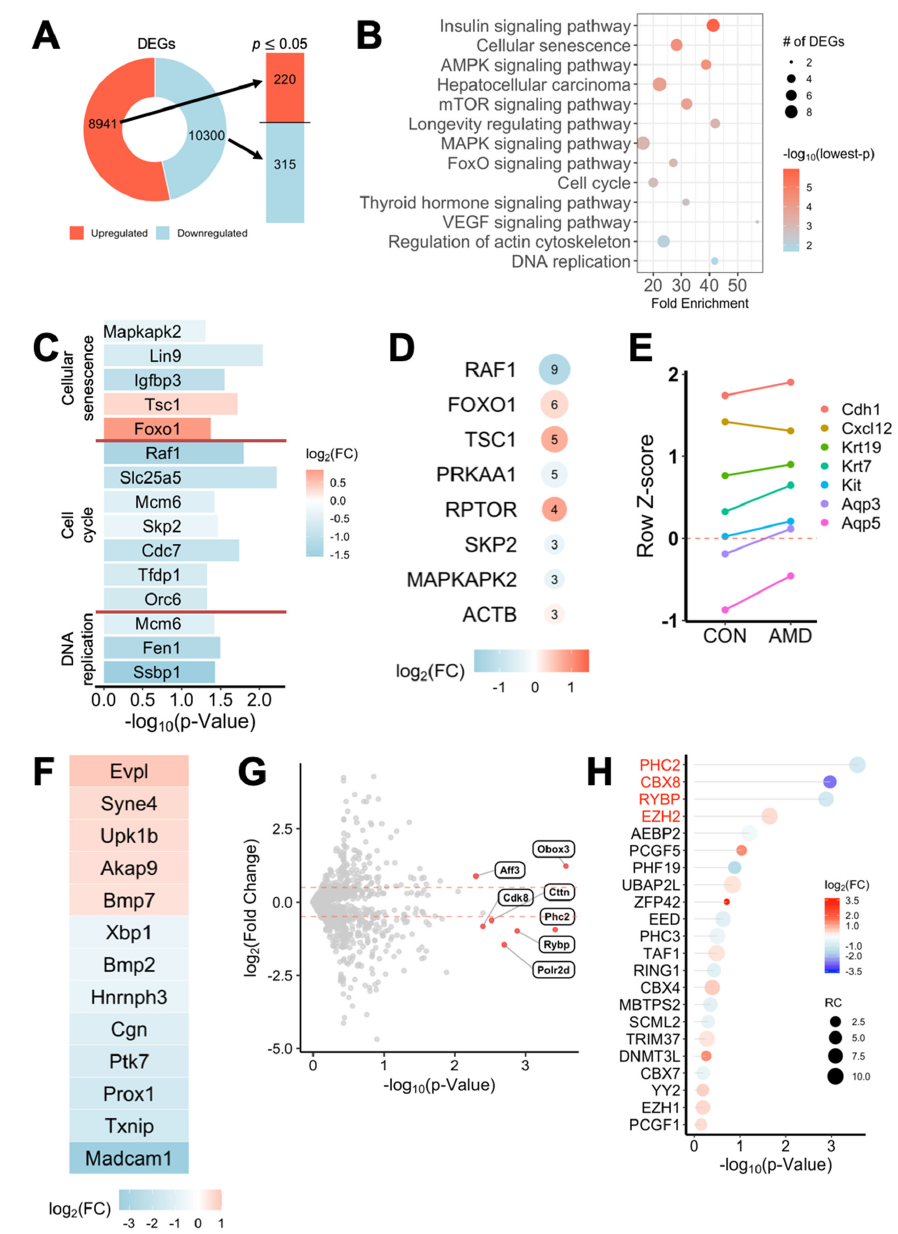
Figure 4. AMD3100-induced transcriptional changes in developmental and polycomb repressive complex 1 (PRC1) genes. ( A ) 3 ′ mRNA sequencing was performed on control and AMD3100-treated E14 eSMGs at 6 h. Among 8941 up-regulated and 10,300 down-regulated genes in the treated group, a total of 535 differentially expressed genes (DEGs) with p < 0.05 and |log2 fold change (FC)| ≥ 1 were found; 220 up-regulated and 315 down-regulated. ( B ) Kyoto Encyclopedia of Genes and Genomes (KEGG) pathway enrichment analysis of DEGs. Significantly enriched pathways are revealed by enrichR. ( C ) DEGs in KEGG pathways cellular senescence, cell cycle, and DNA replication are shown with log2FC and p -values. ( D ) The most frequently occurring genes in significantly enriched pathways are listed with log2FC and their number of occurrences. ( E ) Read count z -scores of epithelial differentiation marker genes consistently increased in AMD3100-treated eSMGs, contrasting to the decrease in Cxcl12 . ( F ) DEGs were filtered out from the Gene Ontology (GO) gene set GO:0030855—epithelial cell differentiation—and the inclusive DEGs are listed. ( G ) Currently-known murine transcription factors (1475 total) were extracted from PantherDB to filter the DEGs. Transcription factor genes with p ≤ 0.01 and |log2FC| ≥ 0.5 are in red. ( H ) Genes comprising PRC1 complex are listed with log2FC and p -values. Names in red indicate genes with p <